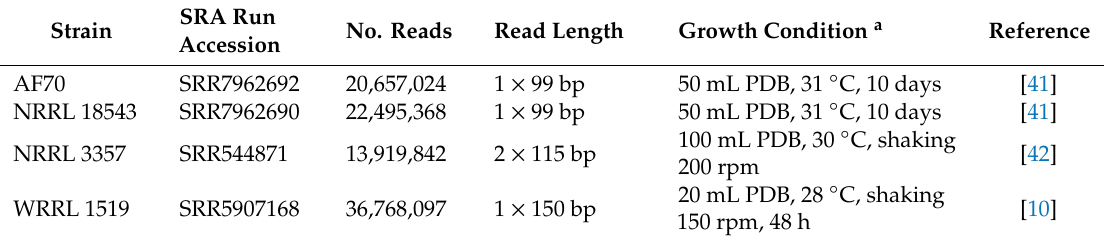
Table 2. General information about RNA-Seq reads from other Aspergillus flavus transcriptomics studies. SRA Run Strain No. Reads Read Length Growth Condition Accession